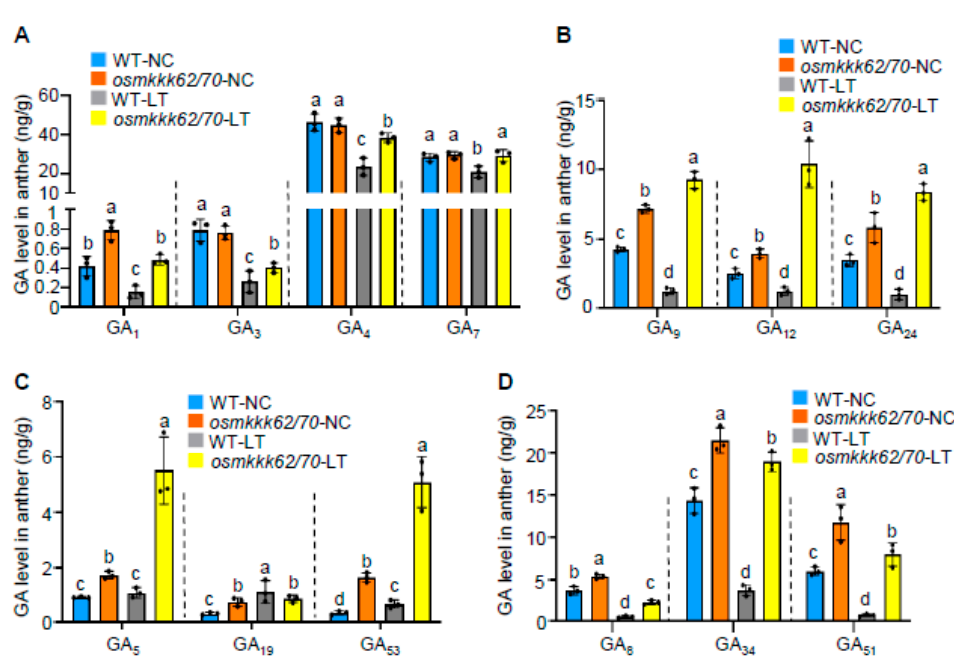
Figure 4. osmkkk62/70 has higher GA content than WT in anthers under low-temperature treatment. ( A ) Measurements of endogenous bioactive GAs in developing anthers of WT and osmkkk62/70 plants grown under NC and after LT treatment. Values are means ± SE (n = 3). ( B – D ) The endogenous contents of GA biosynthetic precursors ( B , C ) and deactivated GAs ( D ) of WT and osmkkk62/70 plants grown under NC or after LT treatment. Values are means ± SE (n = 3). Each dot represents the result from one biological replicate; error bars indicate means ± SE. Statistically significant differences are indicated by different lowercase letters ( p < 0.05, one-way ANOVA with Tukey’s significant difference test).